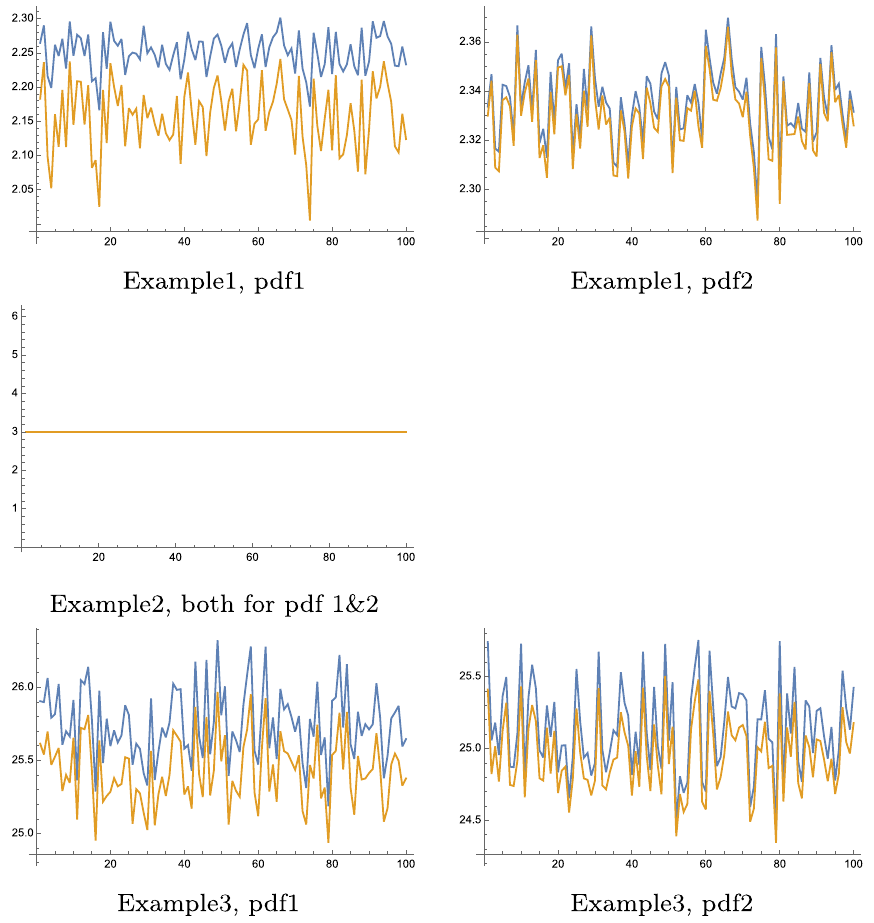
Fig. 1 Comparison of arithmetic (in blue) and geometric (in orange) means for Example1 (top), Example2 (middle), and Example3 (bottom) for 100 independent executions with 100 samples of pdf1 (left) and pdf2 (right). For Example2, pdf2 (not shown) is identical to